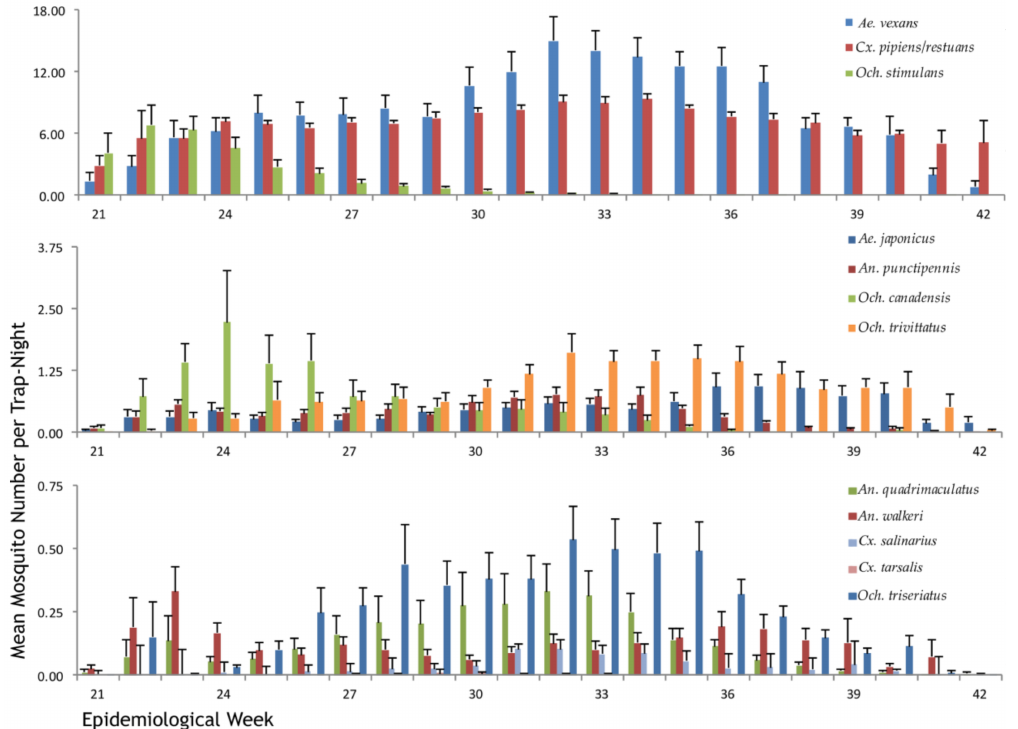
Figure 2. Seasonal distribution of 13 WNV (West Nile virus) vectors collected in Ontario, Canada from 2002 to 2014. Errors bars represent the standard error.